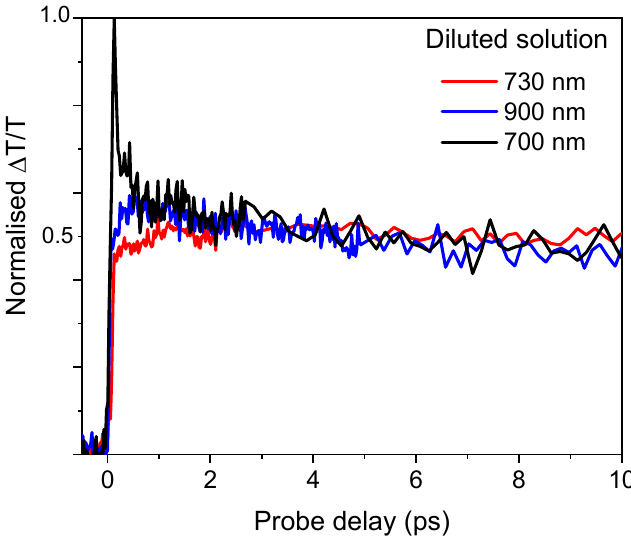
Figure 4. Pump–probe dynamics at different wavelengths.